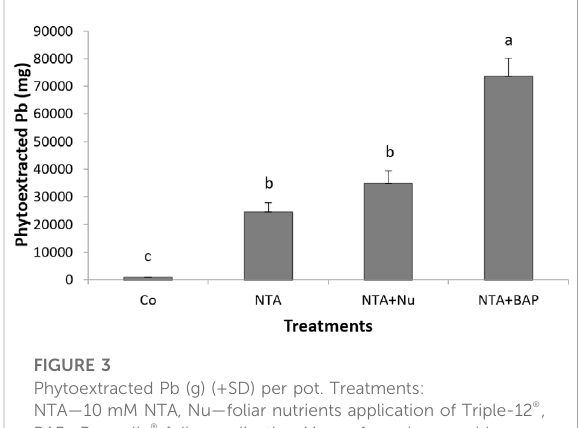
FIGURE 3 Phytoextracted Pb (g) (+SD) per pot. Treatments: NTA — 10 mM NTA, Nu — foliar nutrients application of Triple-12 ® , BAP- Promalin ® foliar application Means for columns with same letters are not signi fi cantly different ( α = 0.05).